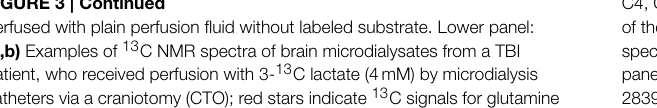
FIGURE 3 | Continued perfused with plain perfusion fluid without labeled substrate. Lower panel: (a,b) Examples of 13 C NMR spectra of brain microdialysates from a TBI patient, who received perfusion with 3- 13 C lactate (4mM) by microdialysis catheters via a craniotomy (CTO); red stars indicate 13 C signals for glutamine